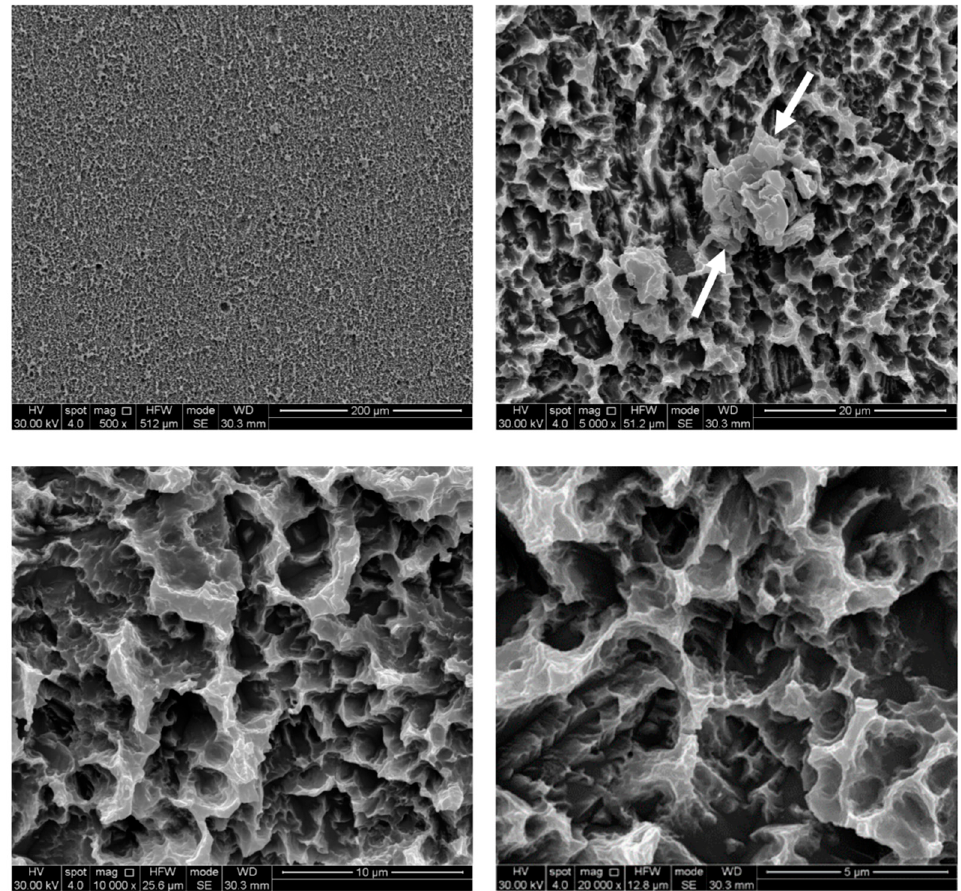
Figure 6. SEM images of diode laser at 4 W (L4) samples. Laser spot melting (white arrows) could be visible at 5000×. Magnifications from 500× to 20,000×.